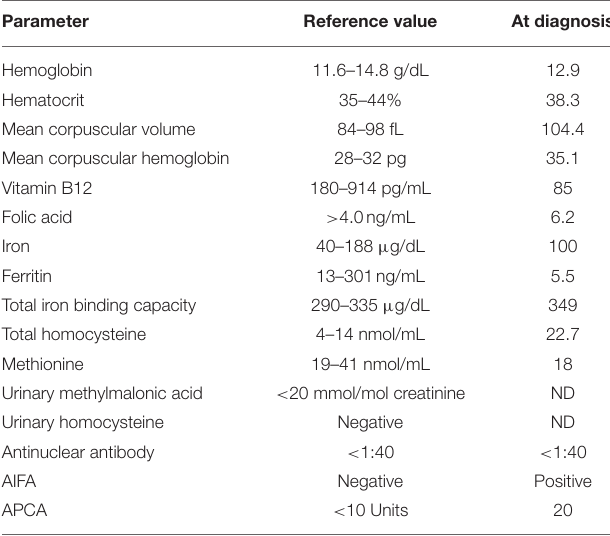
TABLE 2 | Biochemical parameters of the mother.